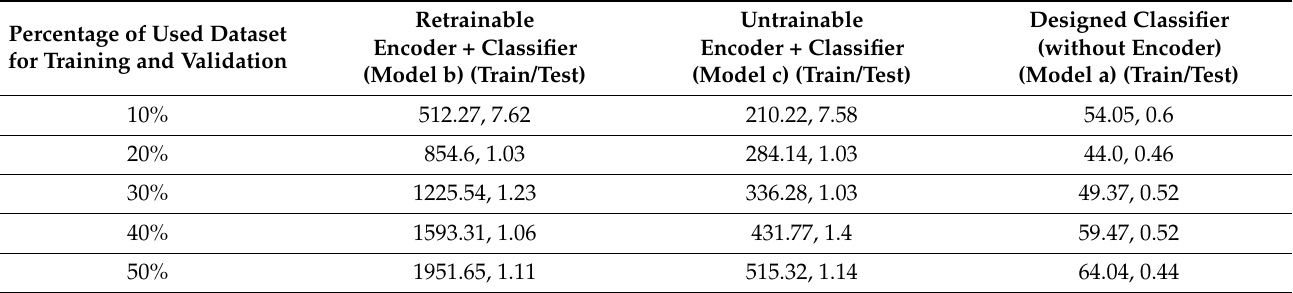
Table 3. The process time (sec) for retrainable encoder, untrained encoder, and designed classifier (without encoder)